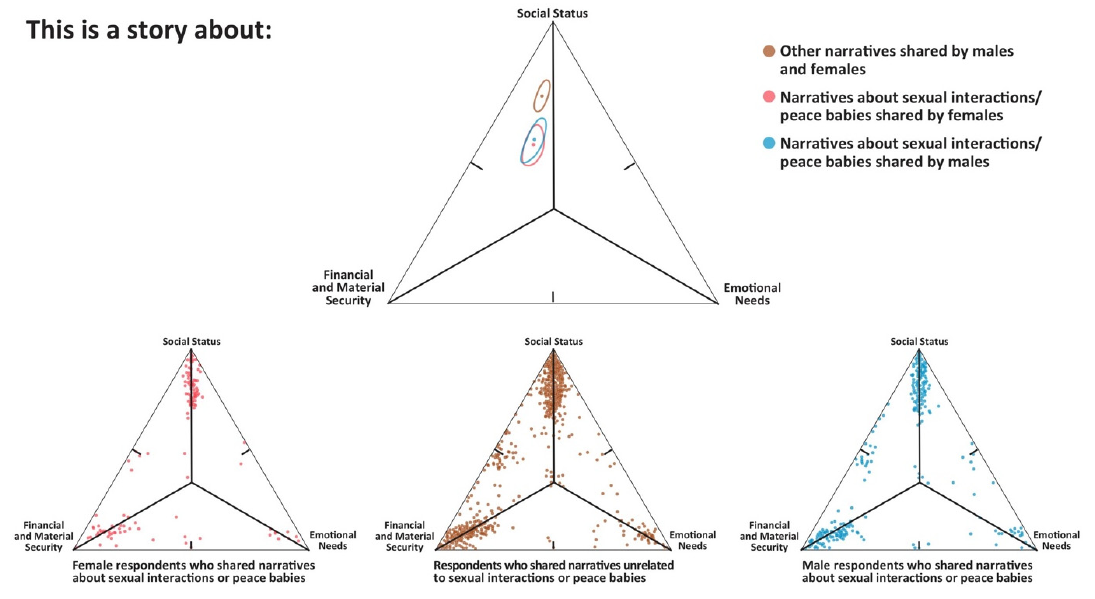
Figure 2. Disaggregated geometric means for Triad 1.